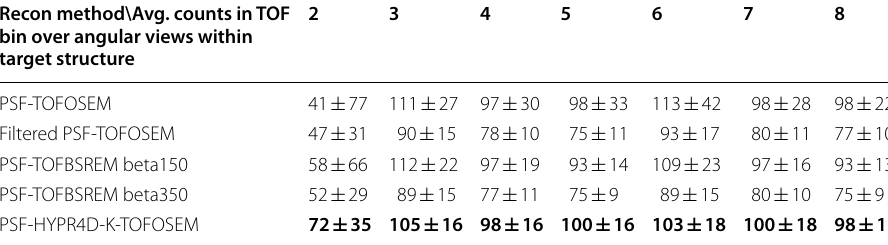
The bold values show the best performance across count levels